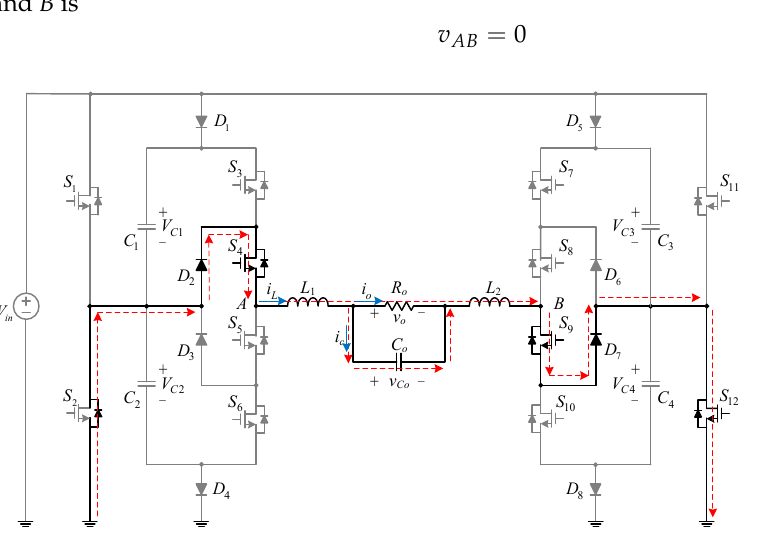
Figure 6. Current flow direction of stage I when switch S 1 is off.